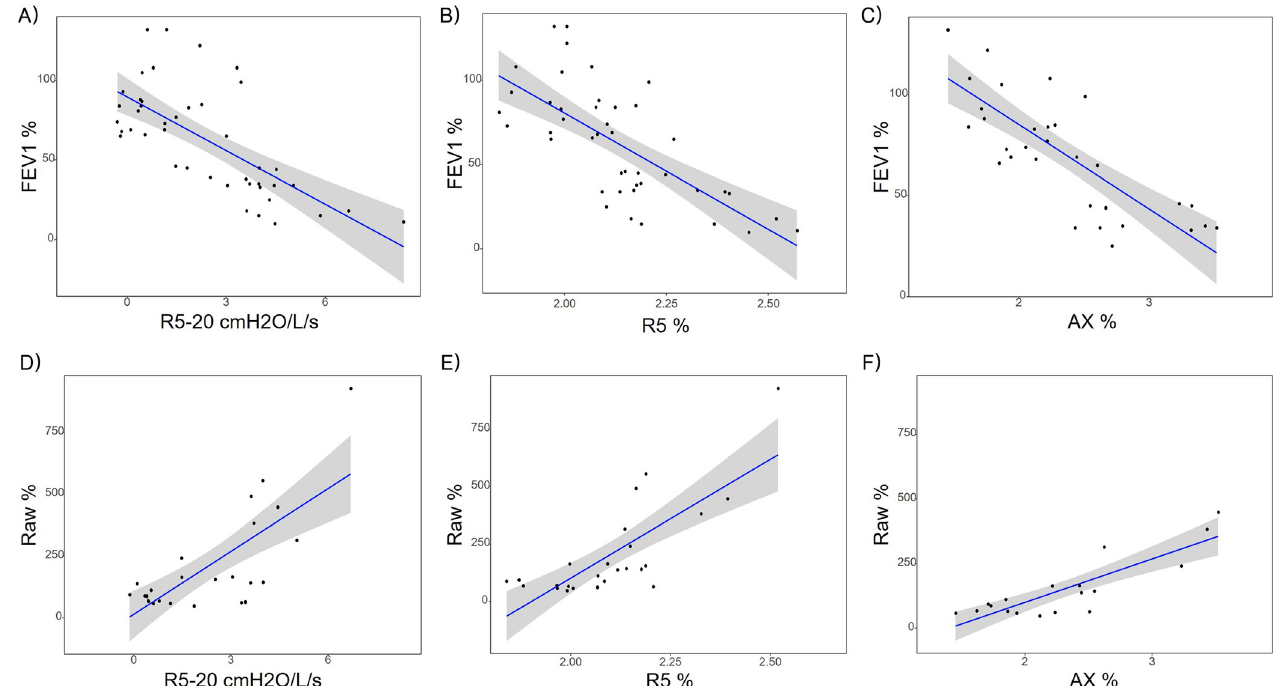
Fig 2. Linear regression plot between PFTs and log-transformed IOS parameters; A-C) Correlation with FEV1; (A) R5-20 cmH2O/L/s (B) R5% (C) AX %, D-F) correlation with Raw %; (D) R5-20 cmH2O/L/s (E) R5% (F) AX %.